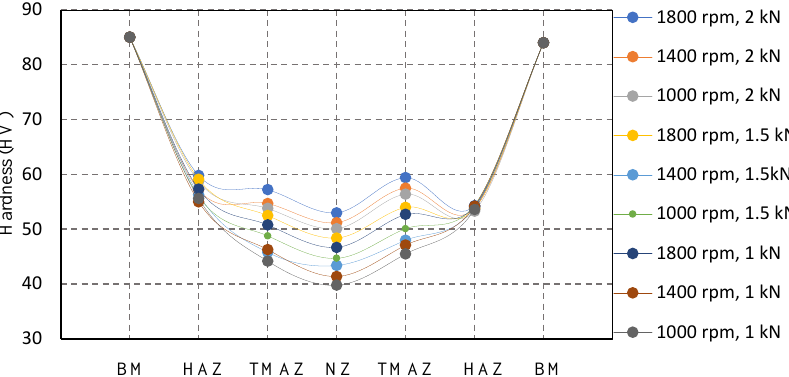
Figure 11. Hardness of welded 6063-T6 samples for various rotation speed and axial force (TS: 8 mm/min).